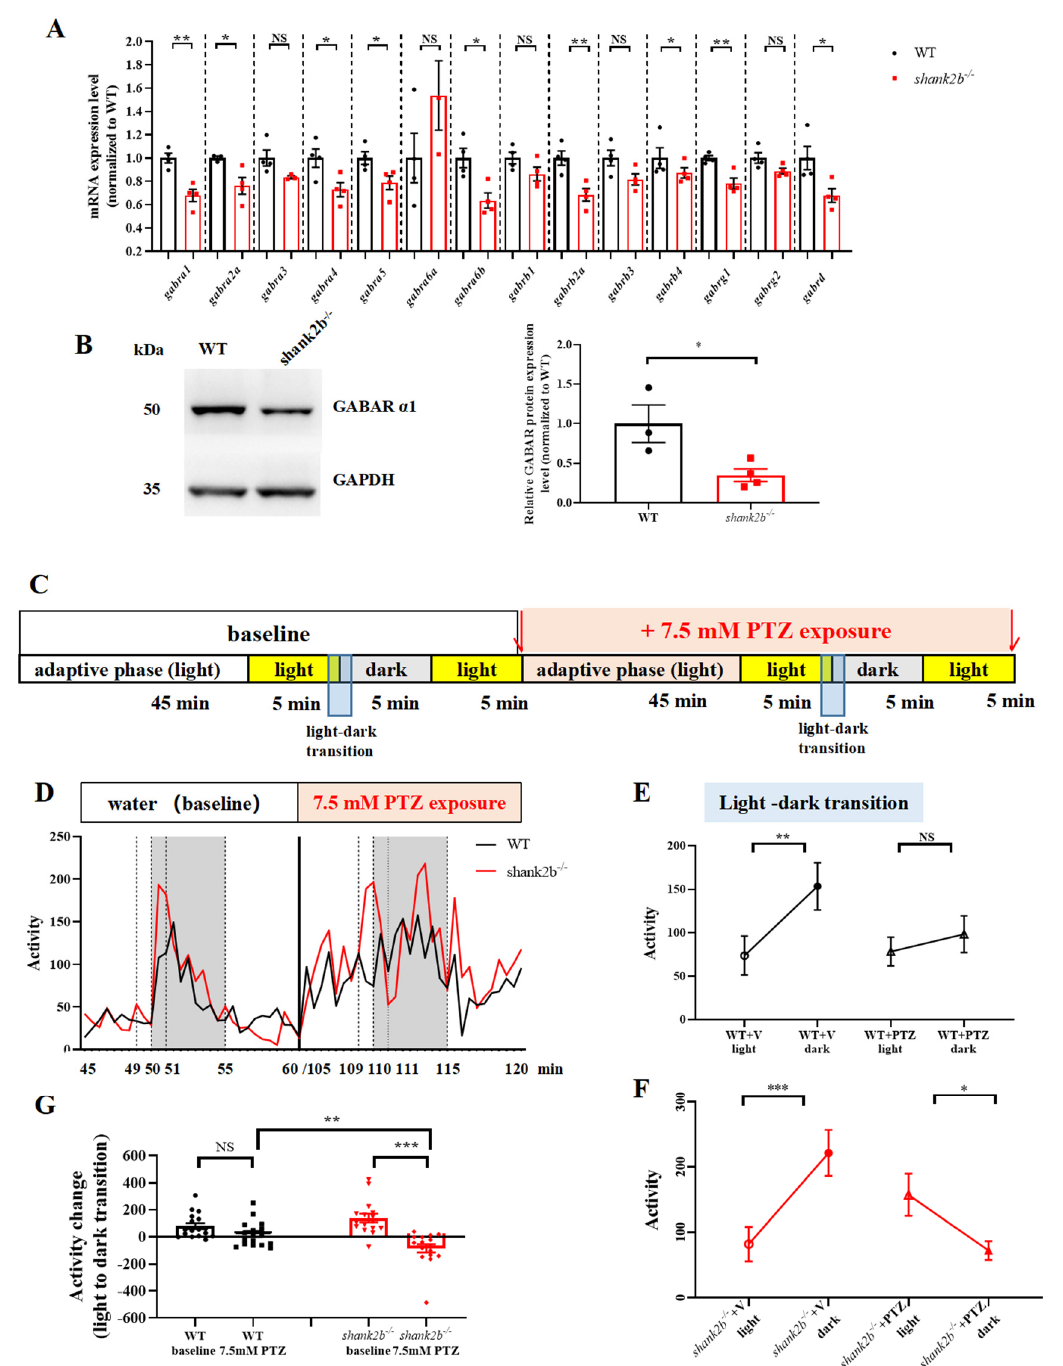
Figure 4. The shank2b mutants display GABAergic deficits. ( A ) RT ‐ qPCR showed altered expression levels of GABAR subunits in adult shank2b − / − brain tissue. gabra1 , ** p = 0.003; gabra2a , * p = 0.0394; gabra3 ns p = 0.0993; gabra3 ns p = 0.0660; gabra4 , * p = 0.0341; gabra5 , * p = 0.0371; gabrg2 ns p = 0.0730; gabra6a ns p = 0.3488; gabra6b , * p = 0.0138; gabrb1 ns p = 0.1258; gabrb2a , ** p = 0.0083; gabrg1 , ** p = 0.005; gabrd , * p = 0.0318; n = 3–4 for each group. Student’s t test. Data are presented as the mean ± SEM. ( B ) Western blot analysis of GABA A receptor α 1 protein in adult shank2b − / − brain tissue. * p = 0.0313, WT n = 3, shank2b − / − n = 4, Student’s t test. Data are presented as the mean ± SEM. ( C ) Pen ‐ tylenetetrazol (PTZ) ‐ treated behavior experimental procedure. ( D ) The experiment consisted of ba ‐ sal activity change during light to dark transition and 7.5 mM PTZ ‐ treated induced activity change